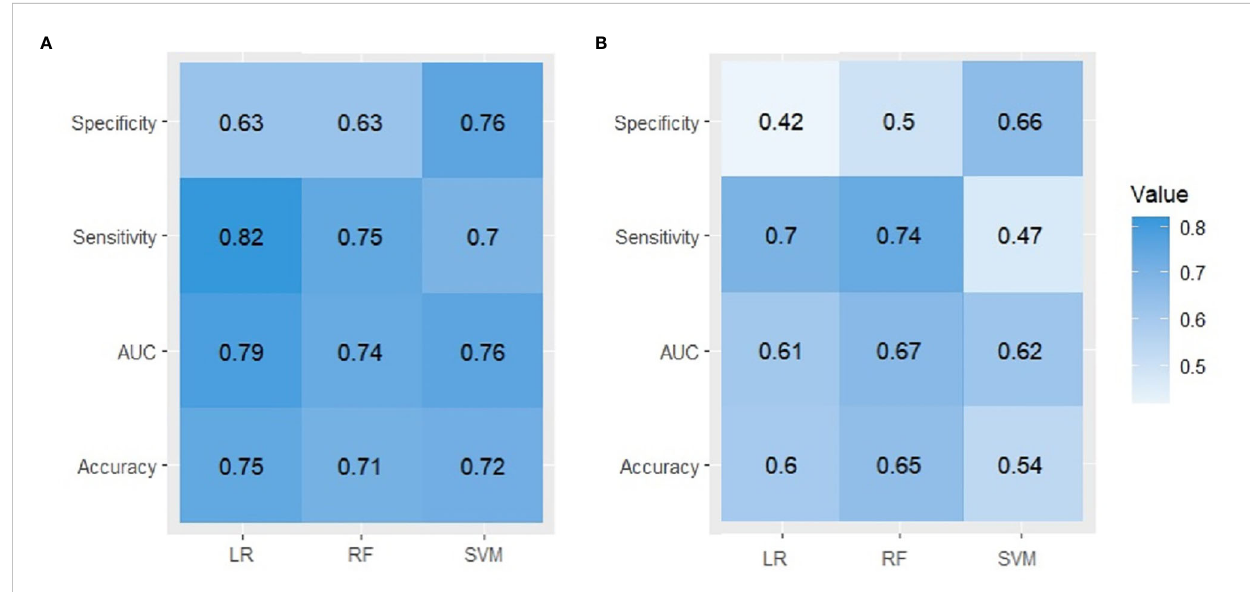
FIGURE 2 A comparison between observed and predicted UI derived from three ML algorithms in external validation. (A) fi rst year, (B) second